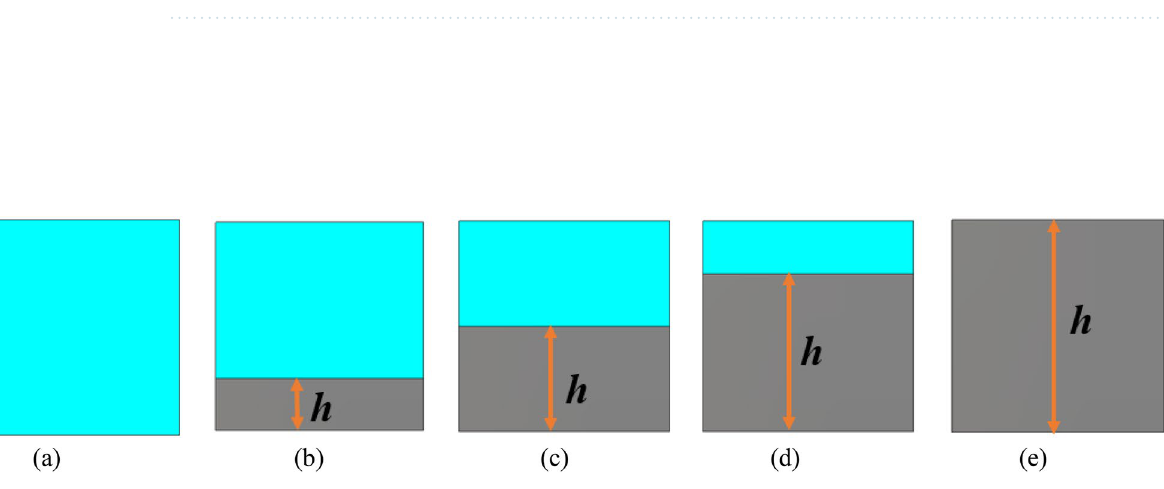
Figure 13. Effect of various change in substrate thickness on S 21 .